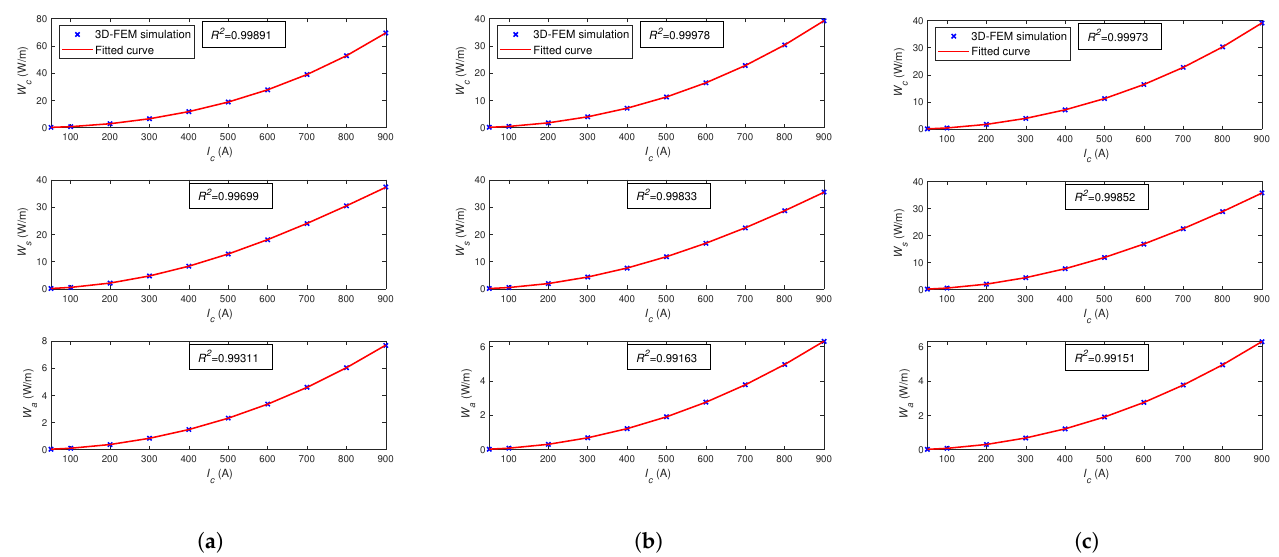
Figure 13. Fitted curves with θ amb = 15 ◦ C, d p = 1 m and k soil = 1 W/(K · m): ( a ) Cable 1E; ( b ) Cable 2R; ( c ) Cable 2E.